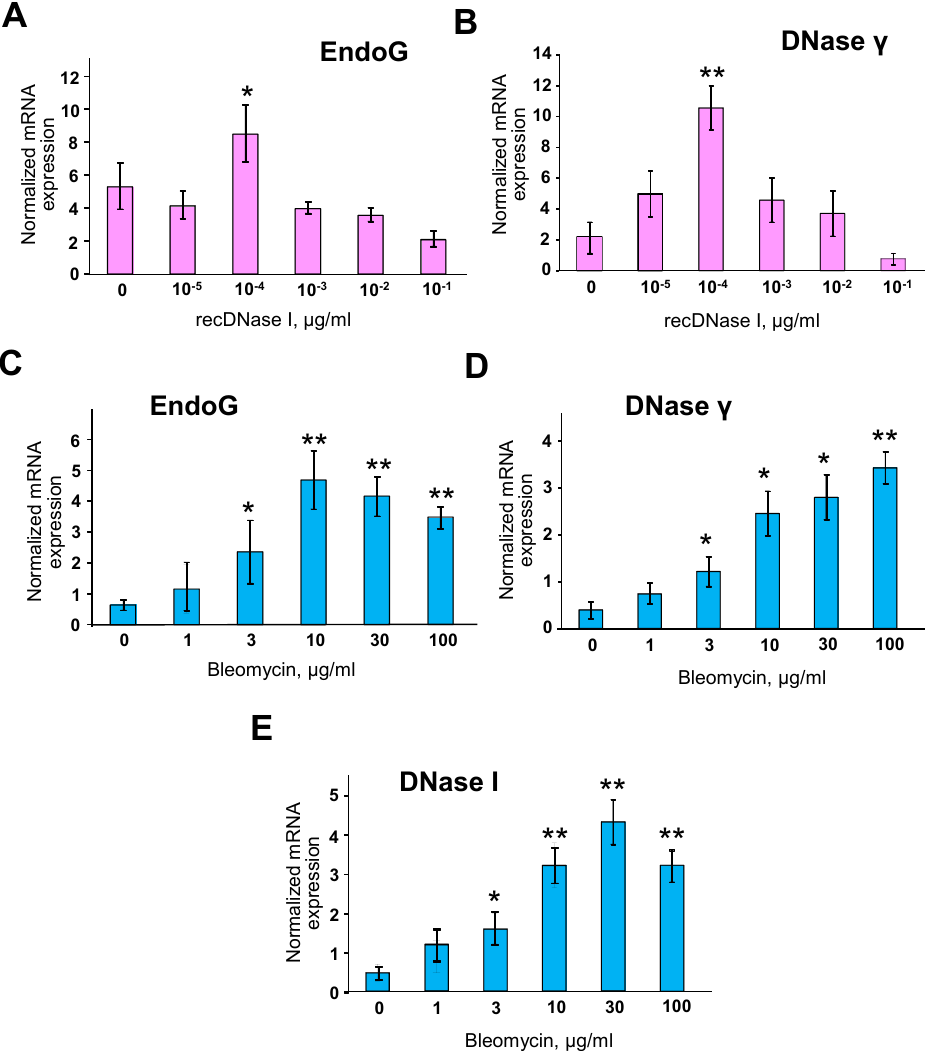
Figure 6. Both DNase I and bleomycin induce EndoG and DNase γ transcription in isolated rat brain cell nuclei, while bleomycin also induces DNase I transcription. In vitro transcription of EndoG ( A ) and DNase γ ( B ) genes in isolated rat brain nuclei exposed with varying concentrations of recombinant DNase I (Pulmozyme) as measured by real-time RT-PCR ( n = 4, * p < 0.05, ** p < 0.01 compared to 0 concentration). ( C – E ) In vitro transcription measured by real-time RT-PCR of EndoG, DNase γ and DNase I genes, respectively, in isolated rat brain nuclei exposed with varying concentrations of bleomycin. mRNA expression levels were normalized by 18 s housekeeping gene ( n = 4, * p < 0.05, ** p < 0.01 compared to 0